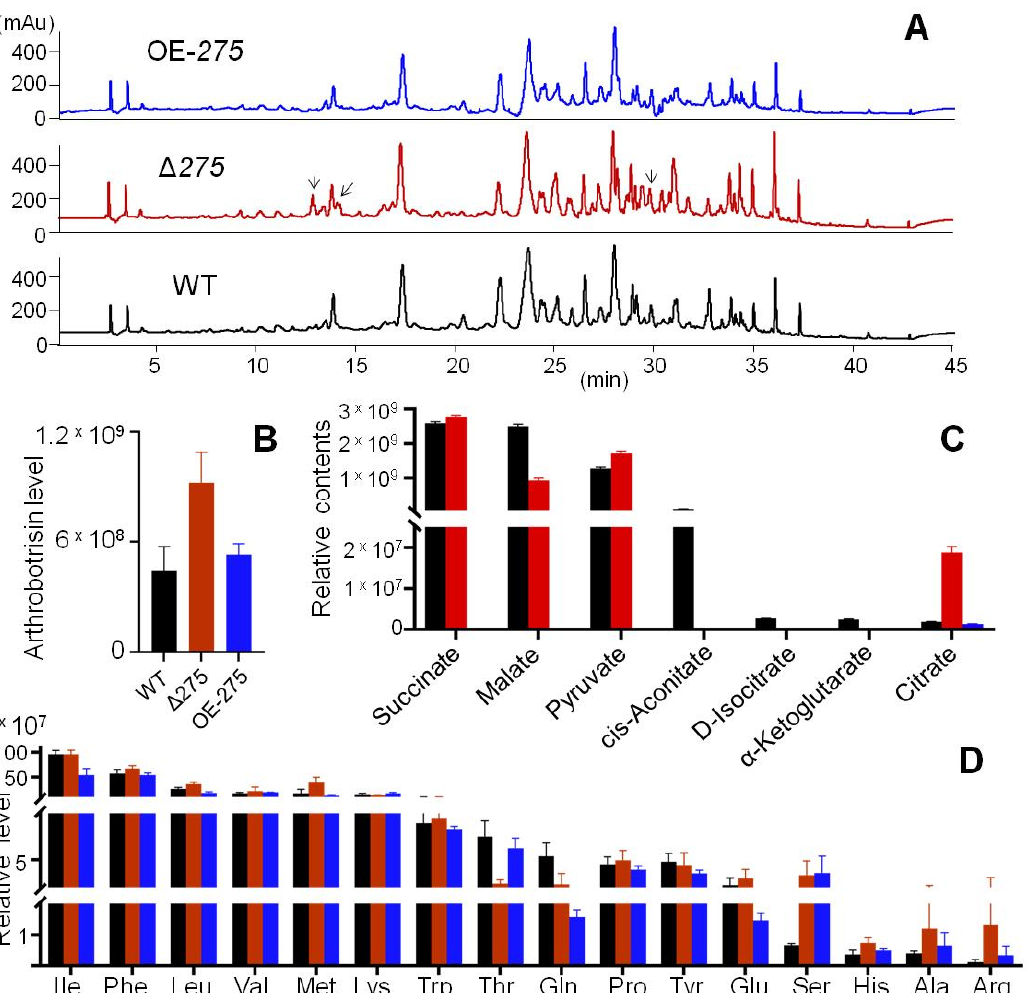
Figure 7. The effects of the gene 275 on the arthrobotrisin production, TCA cycle, and major amino acids: ( A ) HPLC profiles of the extracts of the liquid cultures of ∆ 275 , OE-275 , and the WT. The arrows indicate the extra peaks in ∆ 275 . ( B – D ) Comparison of the levels of arthrobotrisin ( B ), major metabolites from the TCA cycle ( C ), and major amino acids ( D ) among ∆ 275 , OE-275 , and the